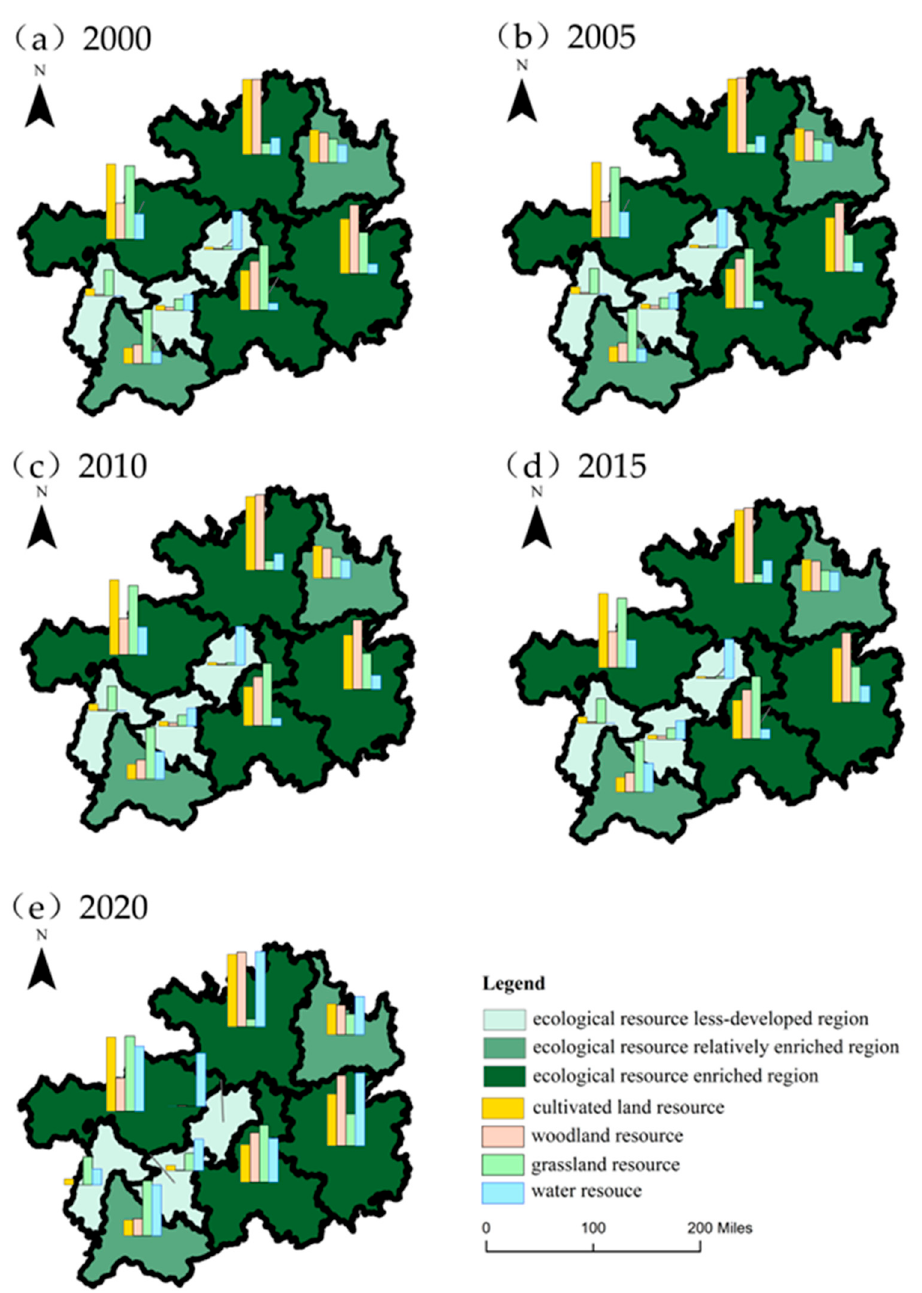
Figure 6. Distribution pattern of ecological resources in Guizhou Province.